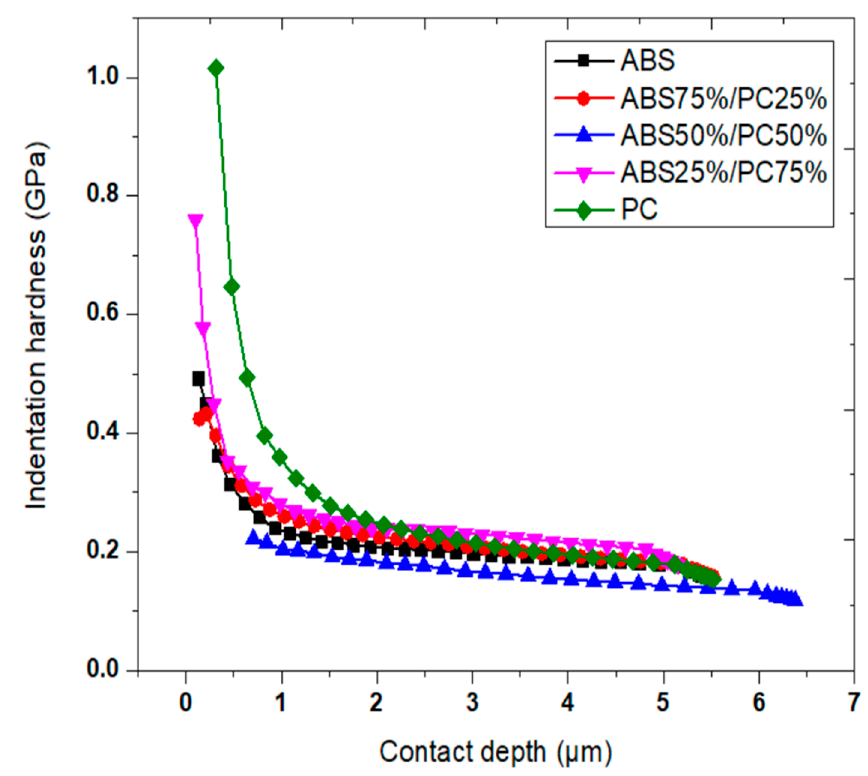
Figure 4. Hardness of ABS/PC samples as a function of contact depth.